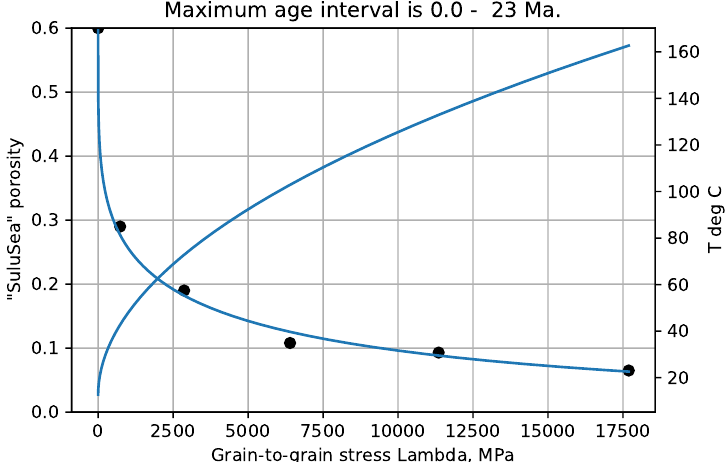
Figure 10. “Sulu Sea” porosity trend.